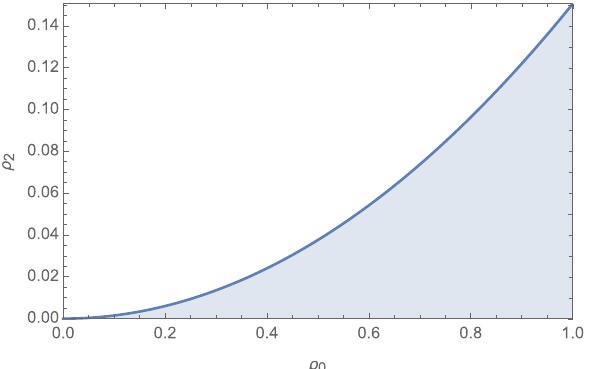
Fig. 1 The space of initial data of the marginally bound Lemaître–Tolman–Bondi dust collapse models with a quadratic initial density profile ρ( 0 , r ) = ρ 0 − ρ 2 r 2 ( ρ 2 ≥ 0) is parametrized by (ρ 0 ,ρ 2 ) . Here we indicate by the shaded region the set of initial data that develop black holes. The complementary region, in white, corresponds to the set of initial data for which the spacetime contains a globally visible naked singularity. Although here we have only displayed the region 0 ≤ ρ 0 ≤ 1 of the parameter space, it is evident from (45) that this partitioning is representative of the entire parameter space ρ 0 − ρ 2 . Also, since we require that the energy condition ρ ≥ 0 be satisfied throughout the cloud, its maximum radius cannot exceed r b, max =